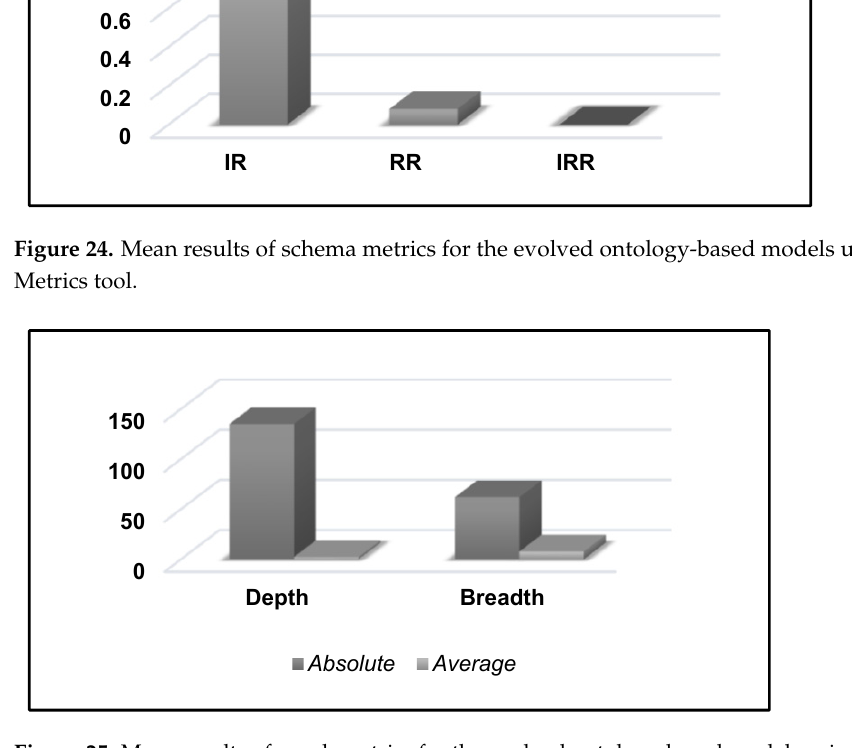
Figure 25. Mean results of graph metrics for the evolved ontology-based models using the OntoMet- rics tool.